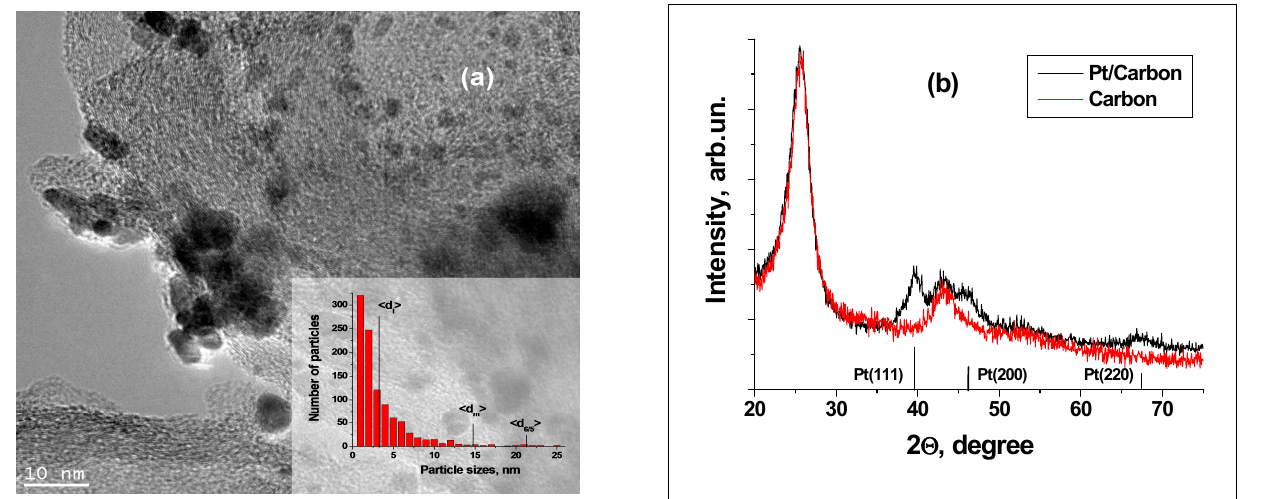
Figure 4. ( a )TEM photo for Pt/C-1 sample with Pt particle size distribution. ( b ) XRD patterns for Pt/C-1 (black line) and initial carbon (red line) samples. The vertical black lines indicate Pt reflexes (JCPDS 04-0802). Table 2. TEM and XRD data for supported Pt nanoparticles and DLS data for Pt-contained sols, which are prepared by the STS technique from supported Pt catalysts.